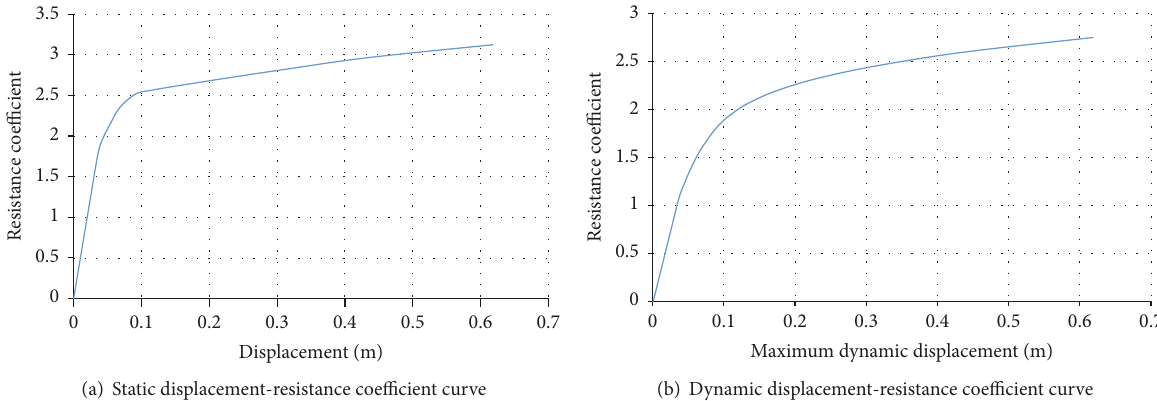
Figure 12: Vertical displacement-resistance coefficient curve of the hybrid structure after the failure of the bottom middle column.